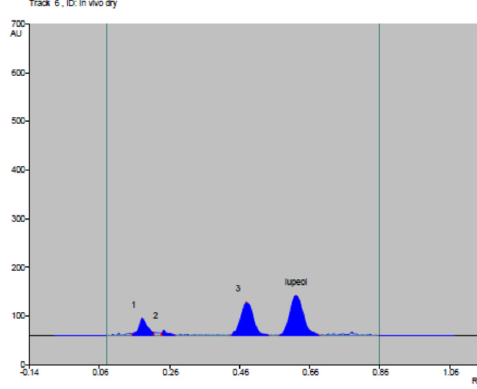
Figure 4a. HPTLC chromatogram of in vivo plant (absolute